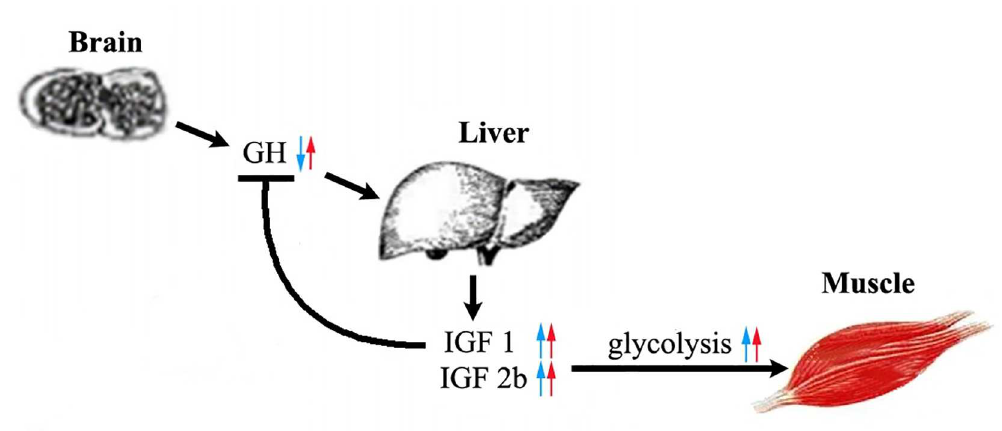
Fig 5. The GH/IGF axis may serve as the upstream pathway of glycolysis to stimulate enhanced growth. Blue arrows denote the expressiondifferences betweenthe Hyb and paternalEla. Red arrows denote the expressiondifferences betweenthe Hyb and maternalEfu. Up and down arrows represent for up- and down- regulationof transcription, respectively, in the